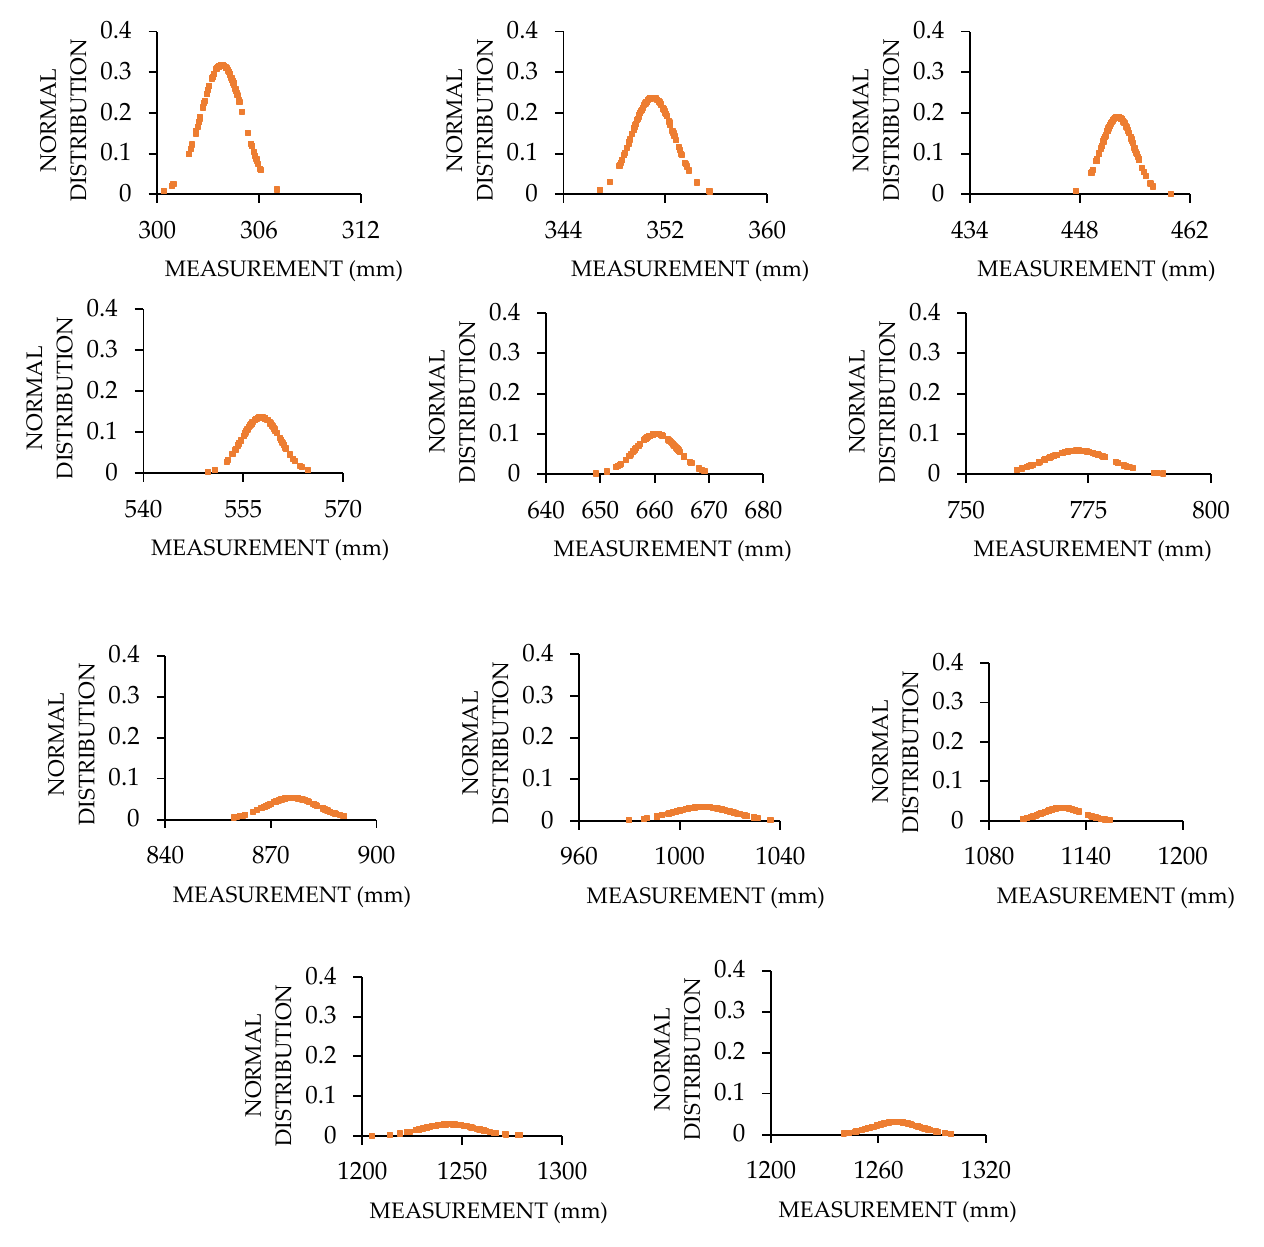
21 of 30 Figure 12. The normal distribution function of VL53L0X for tests with ambient light. Table 4. Statistical analysis of VL53L0X for tests with ambient light. Steel Measurement Pattern 0.59 Figure 13. The normal distribution function of VL53L0X for tests with no excessive ambient light. Table 5. Statistical analysis of VL53L0X for tests with no excessive ambient light. Steel Measurement Pattern